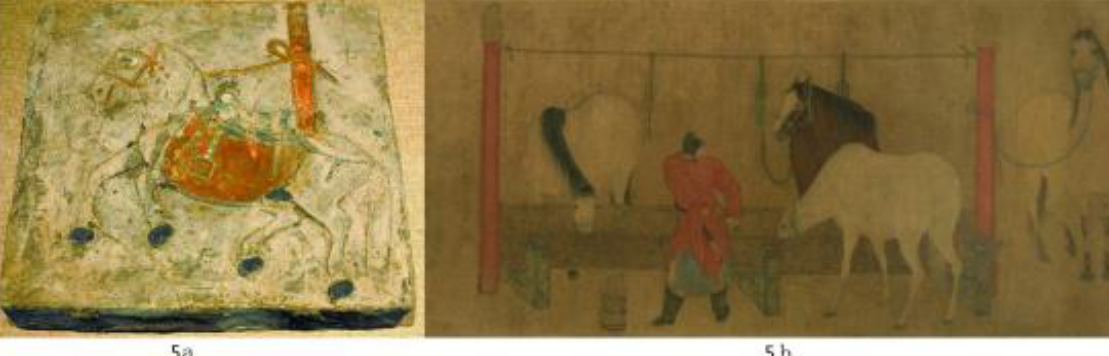
Figure 5. Paintings: a) Tomb brick, Northern Song Dynasty; b) Map of Nine Horses , Renfa Ren, Yuan